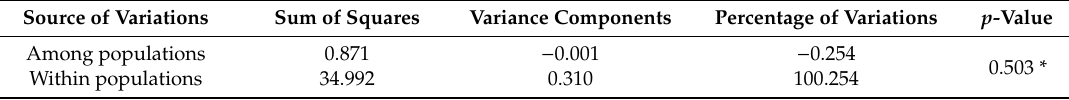
Table 4. Hierarchical analysis of molecular variance (AMOVA) in G. boninense . Negative values for variations among populations is regarded as zero. Genetic structure for sampled G. boninense population was not detected through AMOVA. Genetic variation was attributed to variation within